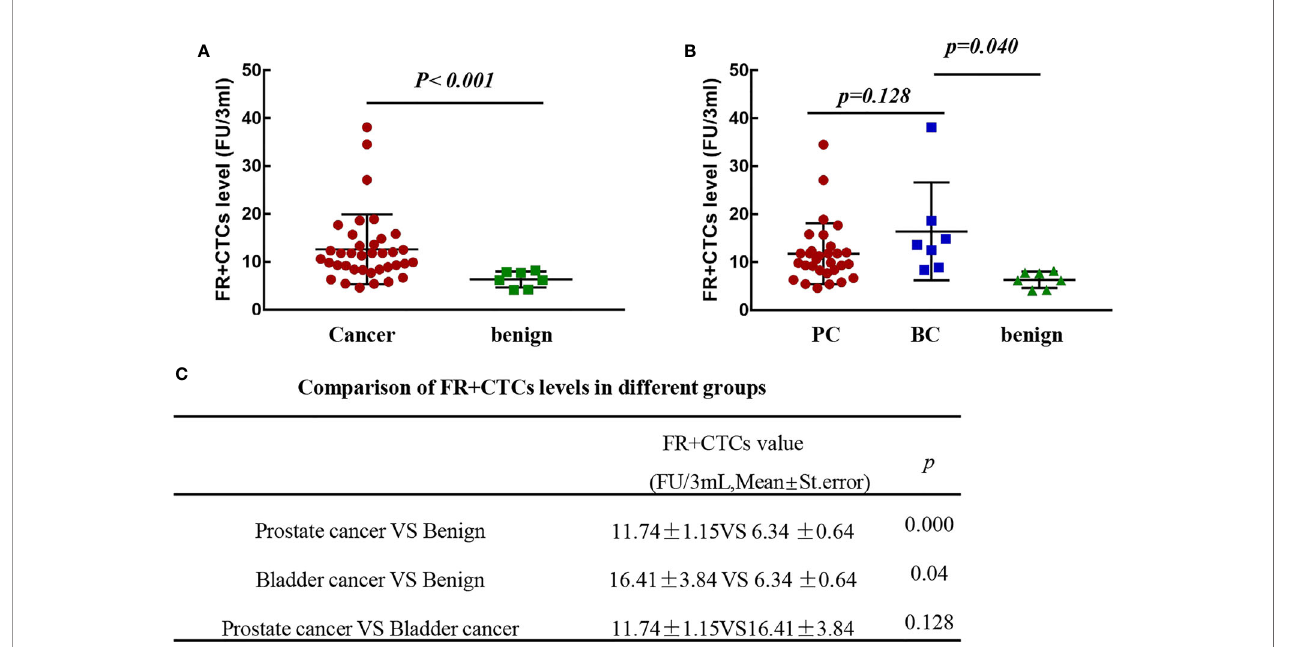
FIGURE 1 | The FR+CTCs levels in patients with the urinary malignant and benign diseases. (A) Comparison of FR+CTCs levels in patients with malignant and benign diseases. (B, C) Comparison of FR+CTCs levels in patients with prostate cancer (PC), bladder cancer (BC), and benign disease.